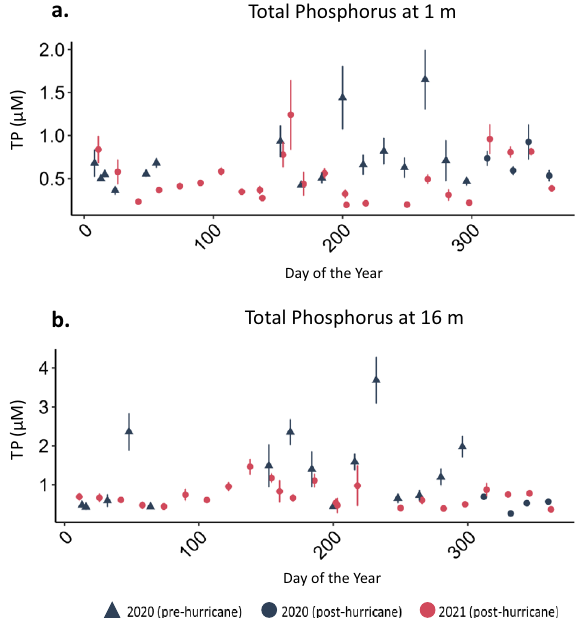
Figure 5. ( a ) Surface TP, and ( b ) deep TP at five continuously monitored in-lake locations (mean ± SE).